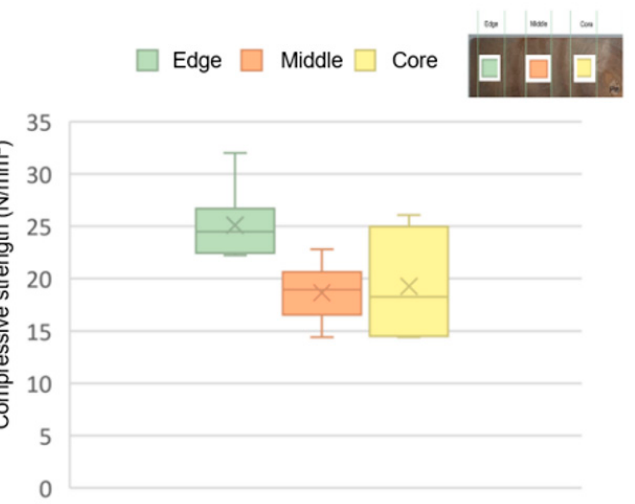
Figure 17. Compressive strength of Paulownia samples extracted from the cross-section.